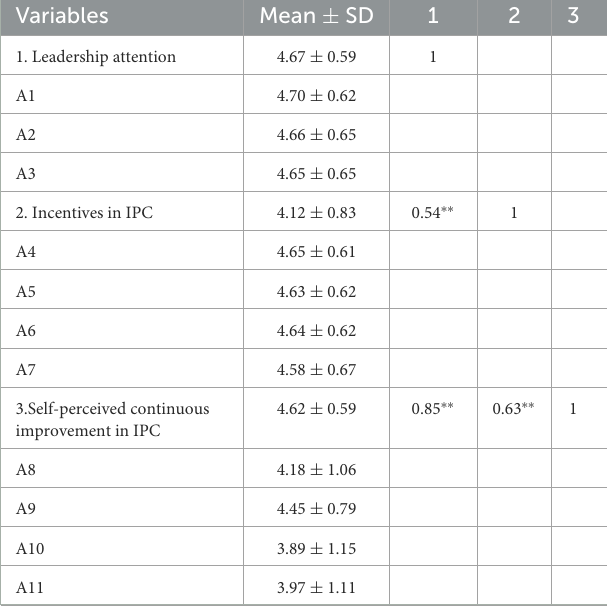
TABLE 2 Means, standard deviations, and correlations for all variables.